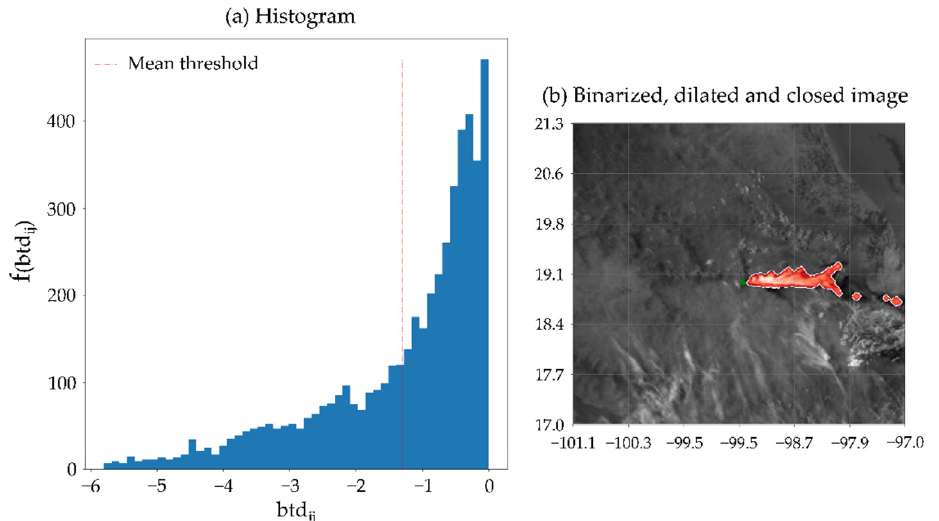
Figure 6. Pre-processing of satellite images using media thresholding ( a ) and morphological operations identify an ash cloud with area of 42,000 km 2 . ( b ) Image corresponding to 20 April 2012 [MODIS Terra, 16:45 UTC].